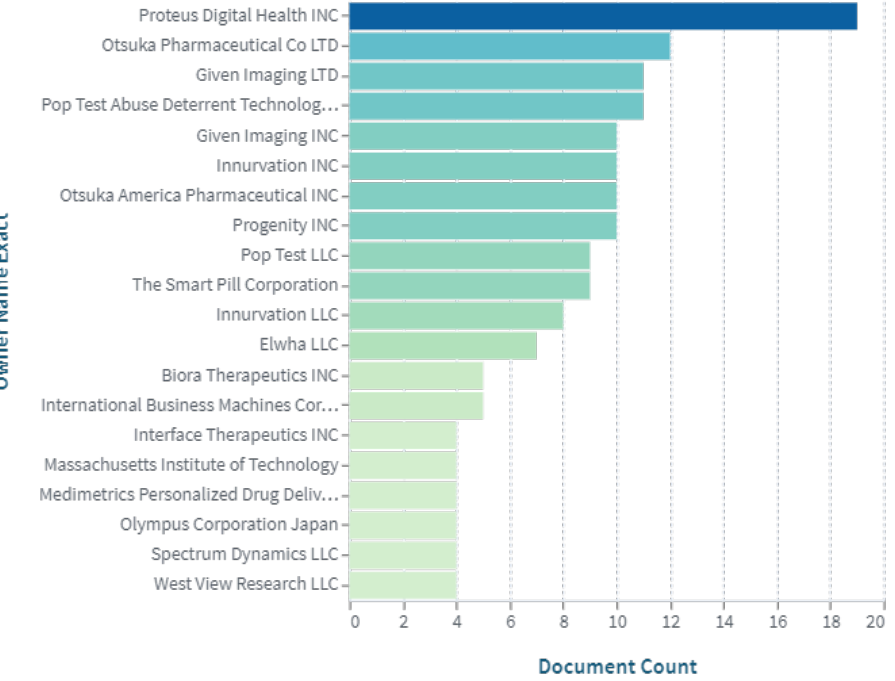
Figure 3. Top proprietors of patents in the field of digital pills with ingestible sensors (https://www.lens.org, accessed on 30 July 2022).